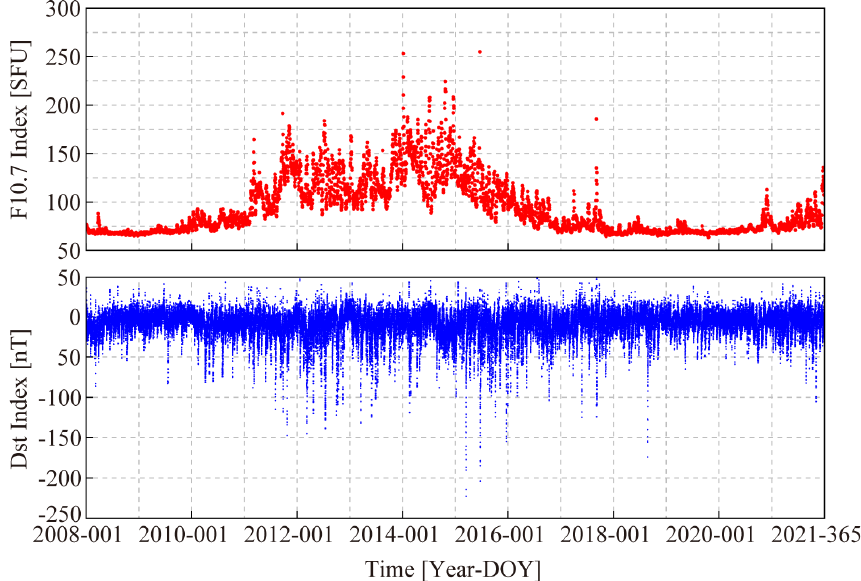
Figure 3. Solar and geomagnetic conditions at the evaluation period.